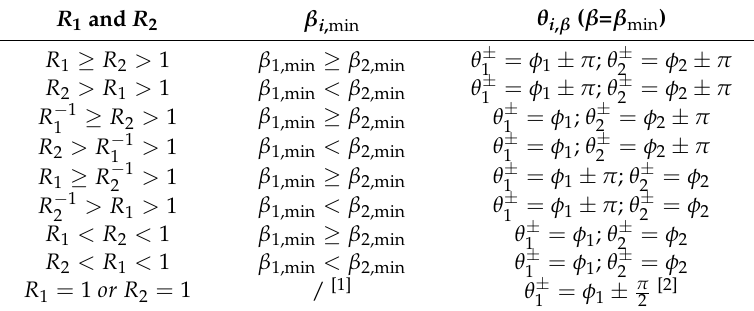
Table 2. Ratio and the spreading parameter β min ( R 1 < 1, R 2 < 1). R 1 and R 2